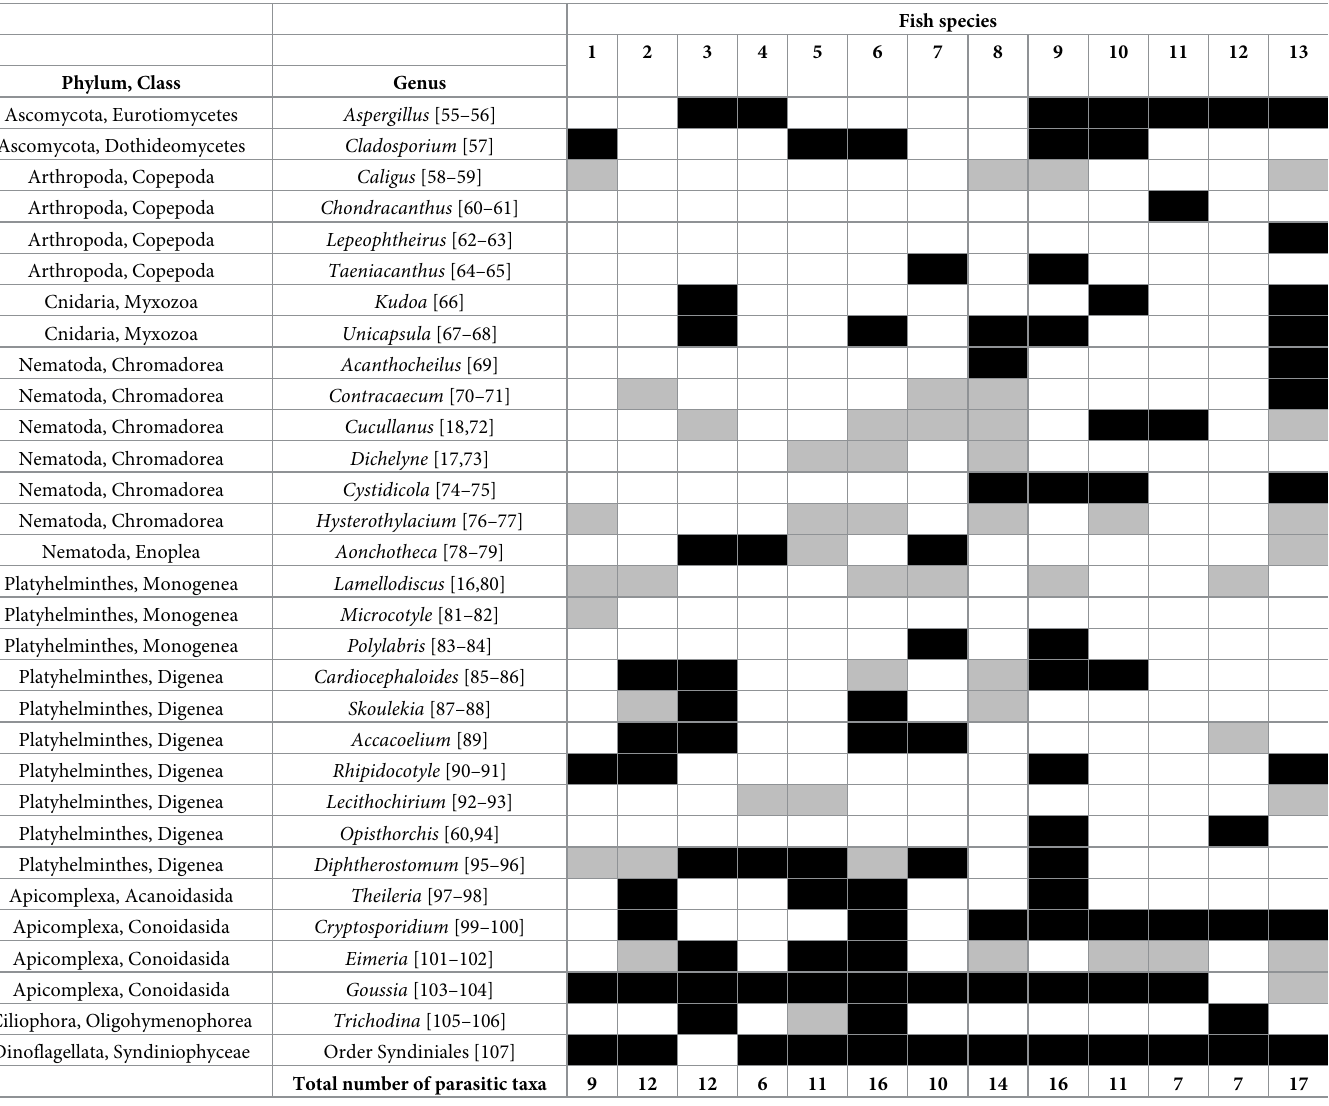
Table 2. Presence (black square) or absence (white square) of eukaryotic parasitic taxa within fish teleost species. The grey squares indicate fish-parasite associations already listed in the literature (S2 Text). References confirm the parasitic status of the genera. Fish species: 1 Diplodus annularis , 2 Diplodus vulgaris , 3 Gobius bucchichi , 4 Gobius cruentatus , 5 Gobius niger , 6 Oblada melanura , 7 Pagellus bogaraveo , 8 Pagellus erythrinus , 9 Sarpa salpa , 10 Scorpaena notata , 11 Serranus scriba , 12 Spicara maena , 13 Symphodus tinca